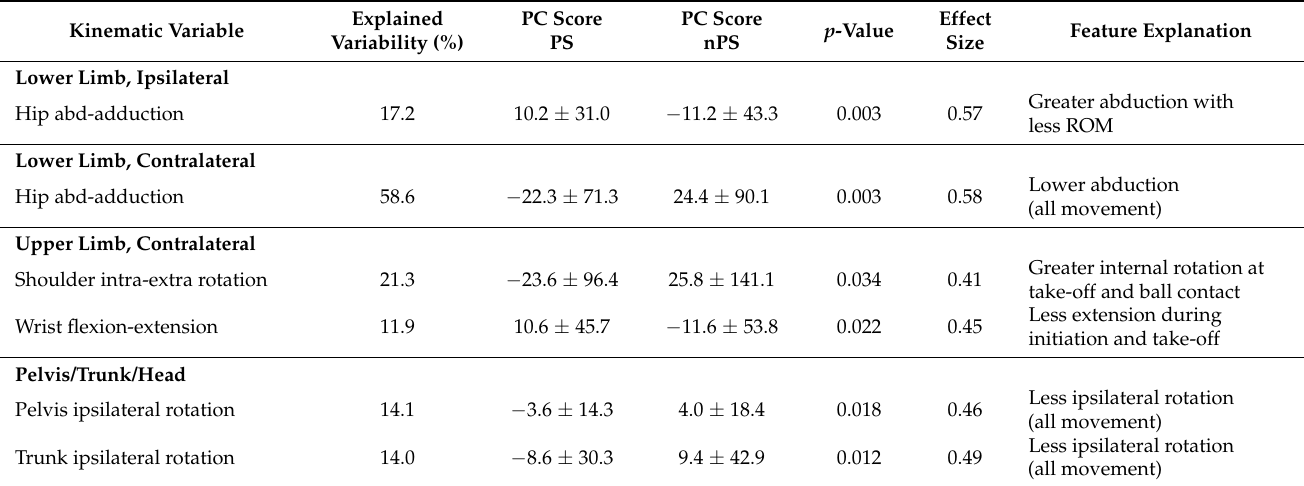
Table 6. Principal Components differences in Low Dive